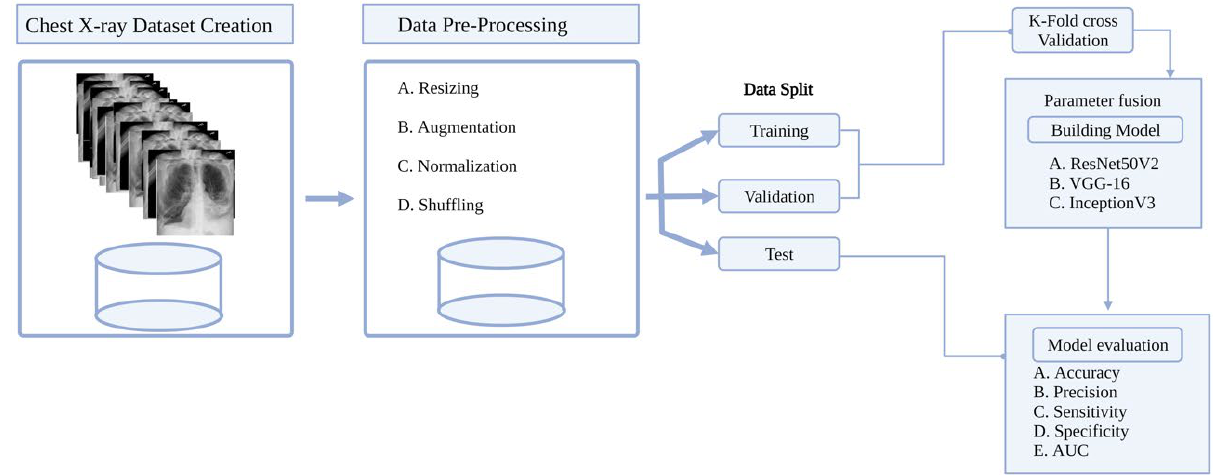
Figure 7. AI-Powered Detection of COVID-19 from X-ray images.